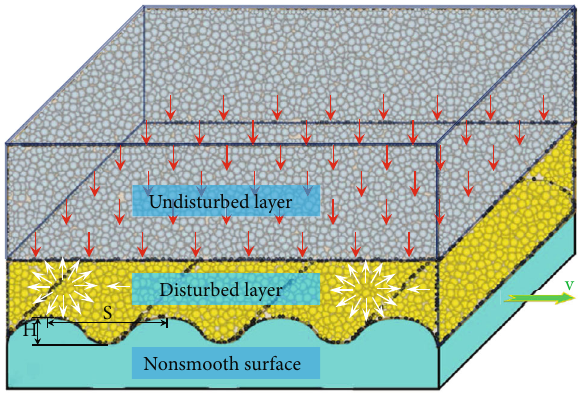
Figure 6: Model of soil movement on nonsmooth